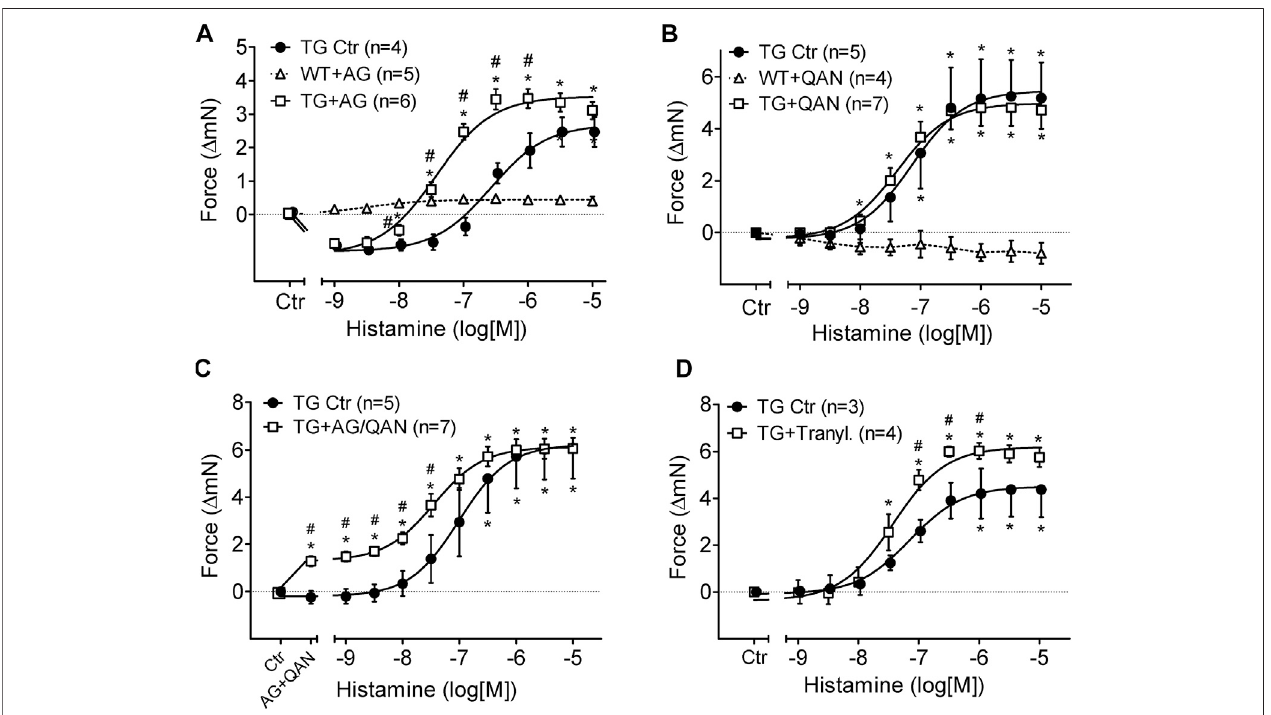
FIGURE 5 | Effects of inhibitors of histamine metabolizing enzymes on FOC of isolated electrically driven (1 Hz) left atrium of H 2 -receptor overexpressing mice (TG) or wild-type controls (WT). (A) Effect of histamine alone (TG Ctr) or in the presence of 1 mM aminoguanidine (TG + AG). (B) Effect of histamine alone (TG Ctr) or in the presence of 2 µM quinacrine (TG + QAN). Here, a WT preparation (WT + QAN) is shown to demonstrate the generally missing histamine effect in WT. (C) Effect of histaminealone(TGCtr)orinthecombined presenceof2 µMquinacrine and1 mM aminoguanidine(TG+AG/QAN). (D) Effectofhistaminealone (TGCtr)orinthe combined presence of 10 µM tranylcypromine and 10 µM propranolol (TG + Tranyl.). Numbers in brackets indicate the number of animals studied. Ctr (cid:2) basal contraction before drug addition. * p < 0.05 vs. Ctr; # p < 0.05 TG drug treated vs. TG